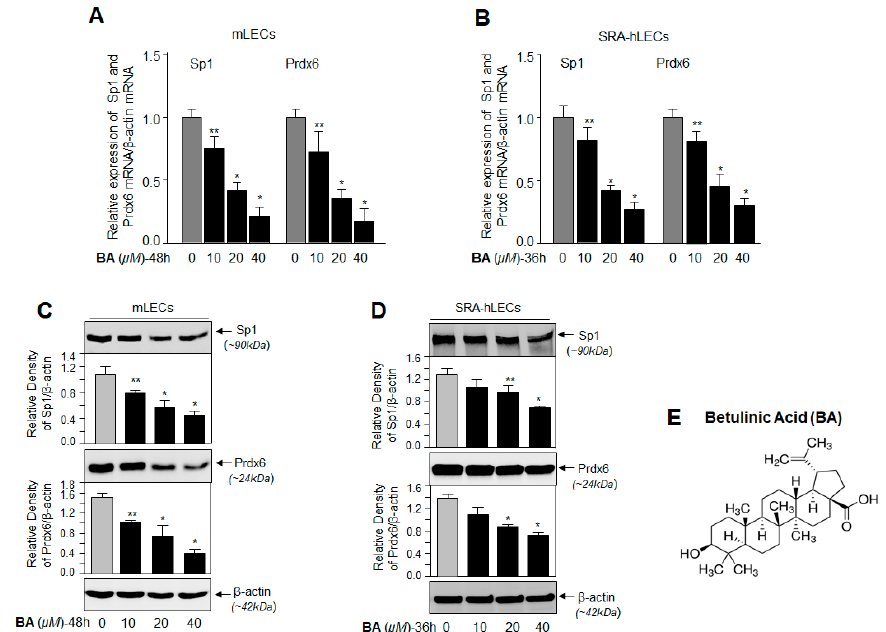
Figure 2. Betulinic acid (BA) reduced Sp1 and Prdx6 expression in a concentration-dependent manner. ( A , B ) mLECs ( A ) and SRA-hLECs ( B ) were treated with different doses of BA, and 36–48 h later, total RNA was isolated and processed for cDNA synthesis, followed by an Sp1 and Prdx6 mRNA analysis by Real-Time Reverse Transcriptase-qPCR (RT-qPCR). The data represent mean ± SD from three independent experiments. ** p < 0.05; * p < 0.001. ( C , D ) Protein was isolated from mLECs ( C ) and SRA-hLECs ( D ), and treated with different concentrations of BA for 48 h and 36 h, respectively. Equal amounts of protein loaded on SDS-PAGE were immunoblotted with antibodies specific to Sp1 and Prdx6. β -actin served as endogenous control. ( E ) Represents BA’s chemical structure.